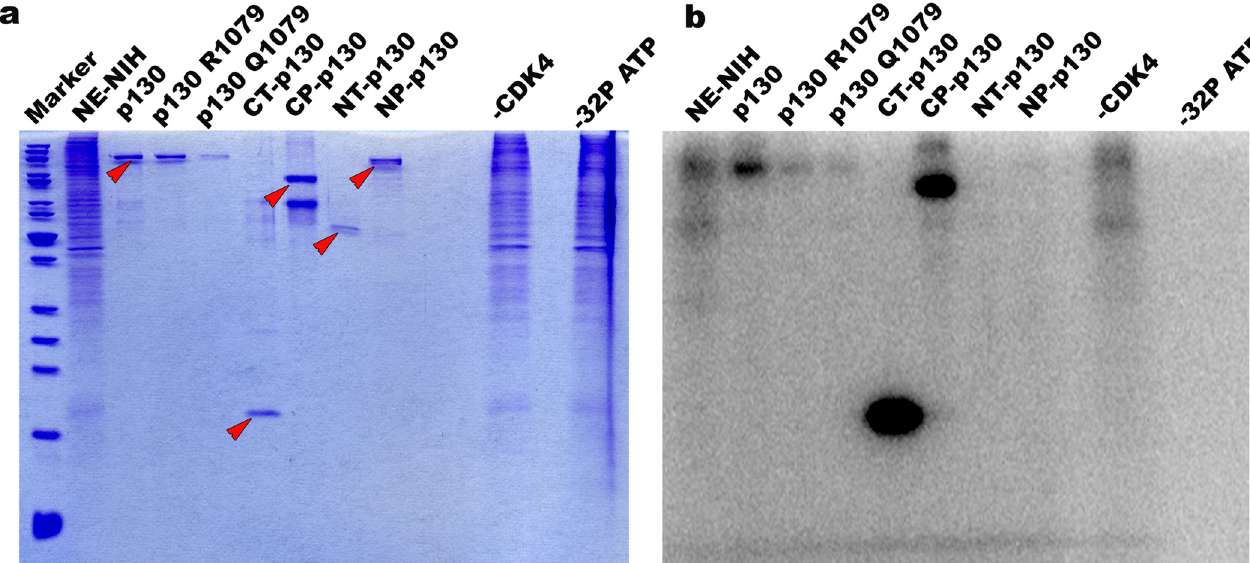
Fig 9. In vitro phosphorylation of full length and truncated forms of Rbl2 proteins. The C- terminus (CT-p130), the C-terminus + pocket domain (CP), the N-terminus (NT-p130) and the N-terminus + pocket domain (NP-p130) were subjected to CDK4 protein kinase assays using 32 P-labelled ATP. Samples were then subjected to SDS-PAGE and subsequent autoradiography. (a) Coomassie stained SDS-PAG. (b) autoradiogram of the Coomassie stained gel. Nuclear extracts of NIH-3T3 (NE-NIH) cells served as a control. Lane marked with -CDK4 contains the nuclear extracts of NIH-3T3 cells and 32 P-labelled ATP without any CDK4, and the lane marked with -32P ATP contain nuclear extracts of NIH-3T3 cells along with CDK4 but without any 32 P-labelled ATP. Red arrows indicate the position of p130